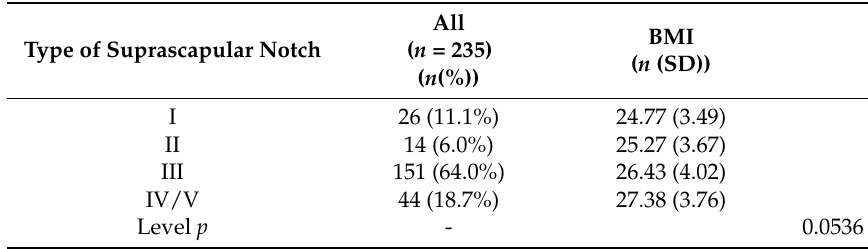
Table 1. Distribution of the suprascapular notch types in the whole group and according to body mass index